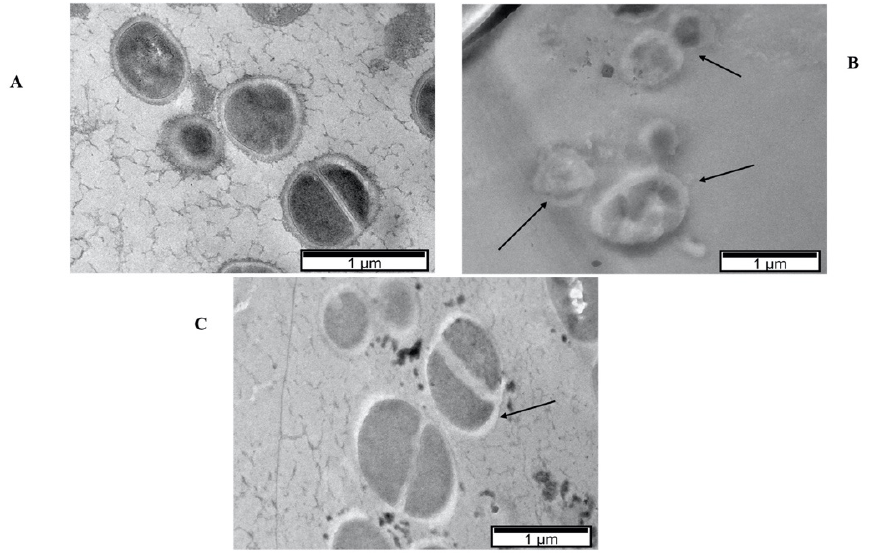
Figure 6. TEM micrographs of MRSA16 cells treated with P 5 W 30 at 2 × MIC value (1211 μ M [ 10 mg·mL − 1 ] ) ( B ) and with the combination of P 5 W 30 with cefoxitin (85 μ M + 400 μ M [ 0.7 mg·mL − 1 + 2 μ g·mL − 1 ] ) ( C ) and control cells (no agent) ( A ). The arrows in ( B ) indicate the severe damage to the bacterial cells caused by the exposure to the compound with loss of cell integrity and in ( C ) the damaged cell wall that will be mainly caused by the combined action of cefoxitin with P 5 W 30 .